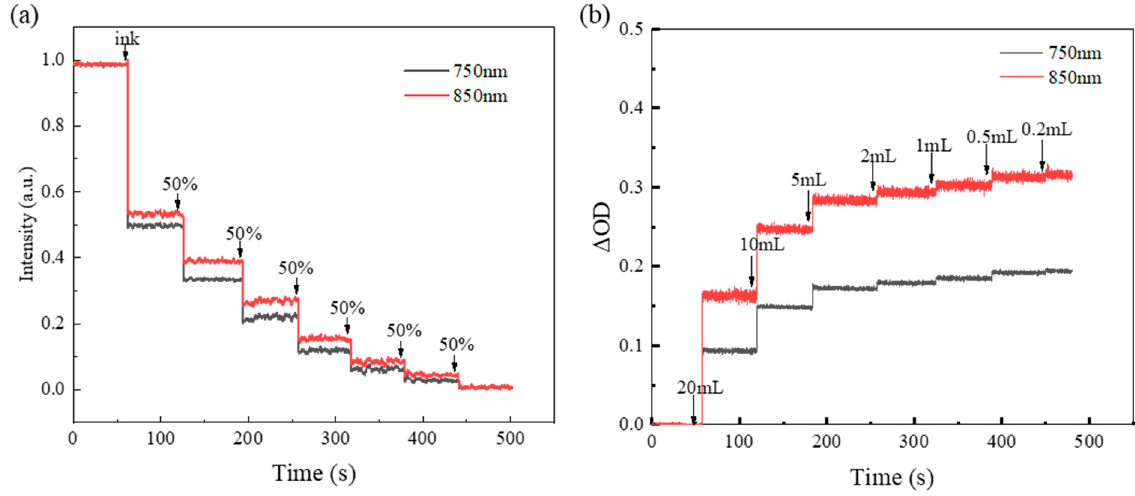
Figure 4. Results of in vitro experiment. ( a ) Liquid optical model experiment results for 750 and 850 nm. ( b ) Blood model experiment results for 750 and 850 nm. 850 nm. ( b ) Blood model experiment results for 750 and 850